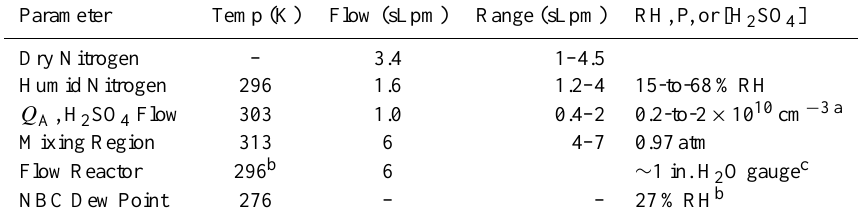
Table 1. Nucleation Baseline Condition temperatures and flows and experimental temperatures, range of flows, and other conditions.